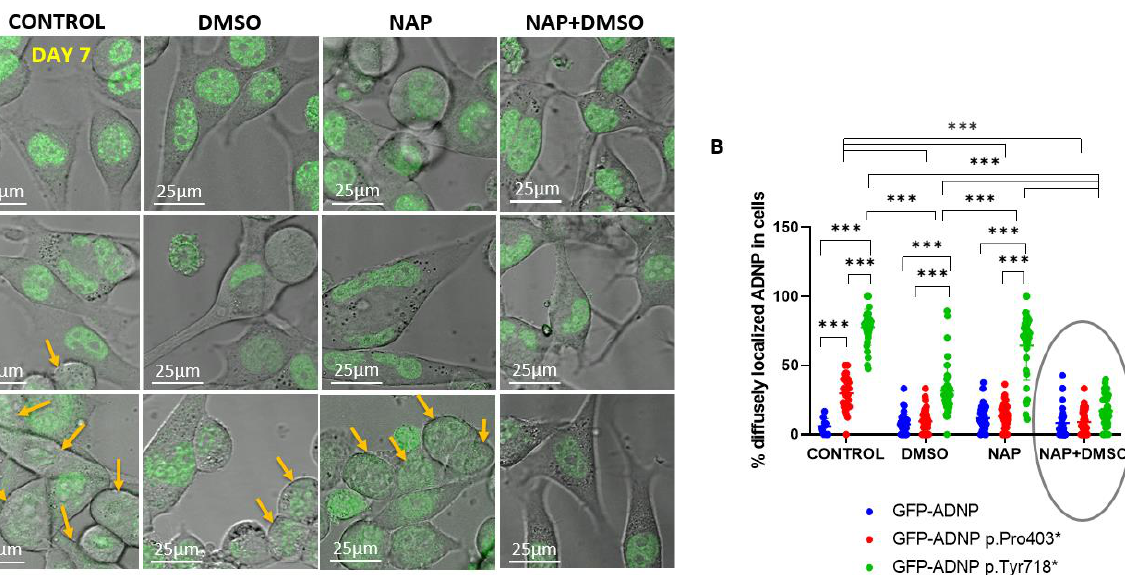
Figure 6. Confocal live imaging of non-differentiated cells (day 1 in culture) showing the distinct cellular distribution of GFP-ADNP p.Tyr719*. ( A ) Representative confocal/fluorescent merged images (Leica SP8) after one day in culture are shown. Selected cells showing diffusely localized GFP-ADNP p.Tyr718* are indicated with yellow arrows, which is indicative of cells with indiscernible nuclear/cytoplasmic boundaries. ( B ) Thirty-four images (1024 × 1024 pixels/image) were analyzed, and the percentage of diffusely localized ADNP outside the nucleus (no nuclear boundaries) was calculated. CONTROL = non-differentiating medium; DMSO = differentiating medium (reduced serum + DMSO); NAP = non-differentiating medium + NAP; NAP + DMSO = differentiating medium + NAP, * p < 0.05; ** p < 0.01; *** p < 0.001.